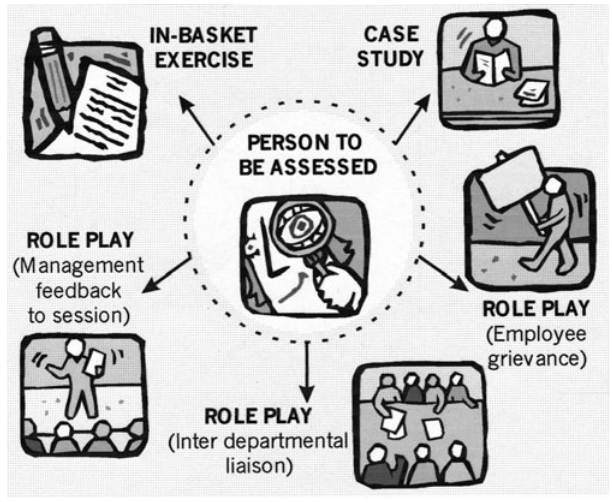
Figure2:Structuringa competency-based